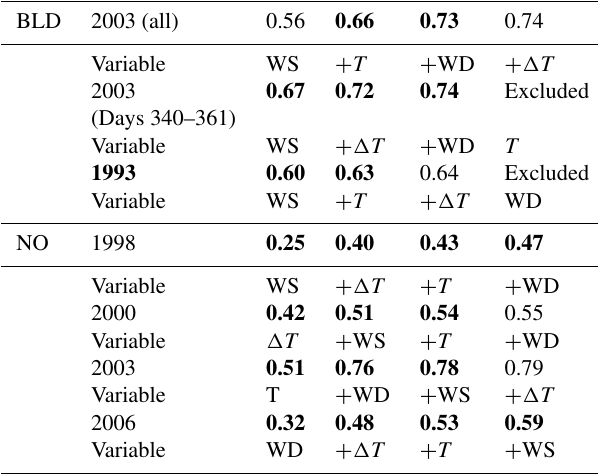
Table A4. Stepwise linear regression analysis ( r 2 ) for BLD and NO (mid-November–December). Stepwise improvements of 0.02 or better are